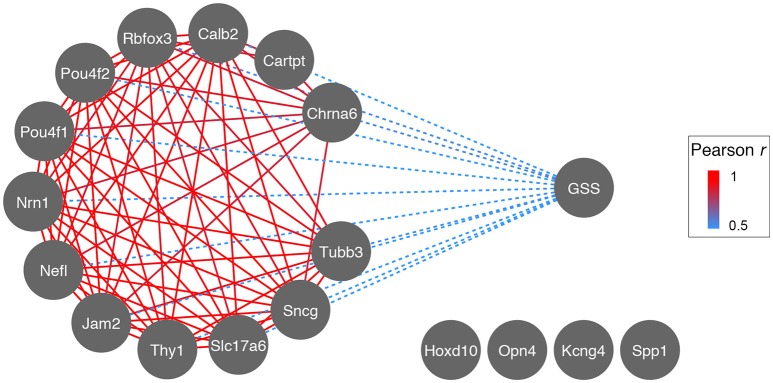
Correlation network of Glaucoma Severity Score (GSS) to RGC markers during glaucoma progression. The GSS is a visual grading system identifying axonal damage in the optic nerve and consists of 4 stages: no damage, light, medium, and severe damage. These stages are inversely correlated (dashed blue) to the expression levels of most RGC markers, suggesting that as RGCs die and axonal damage increases, mRNA expression of RGC marker genes decreases (most likely due to decrease in RGC number). The decrease of RGC marker gene expression is strongly correlated across glaucoma stages (red, r for all >0.9). Markers for ipRGCs (Opn4) and alpha-RGCs (Kcng4 and Spp1) do not correlate to GSS, possibly indicating their preferential survival.